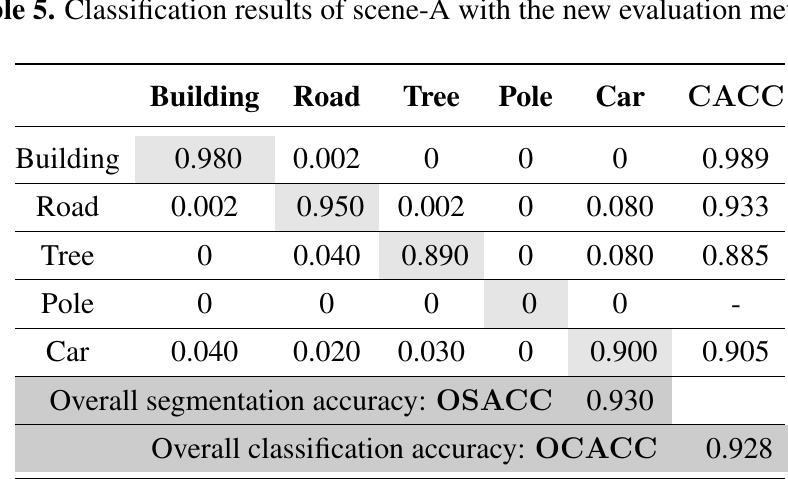
Table 5. Classification results of scene-A with the new evaluation